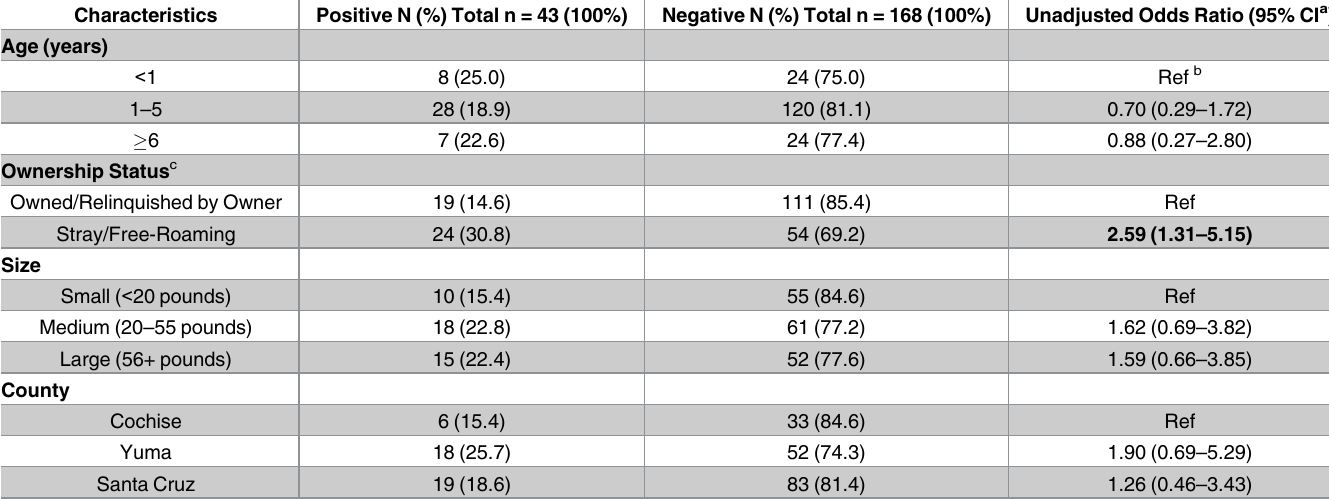
Table 5. Comparison of characteristics between Arizona dogs with positive and negative presenceof IgG antibodies.